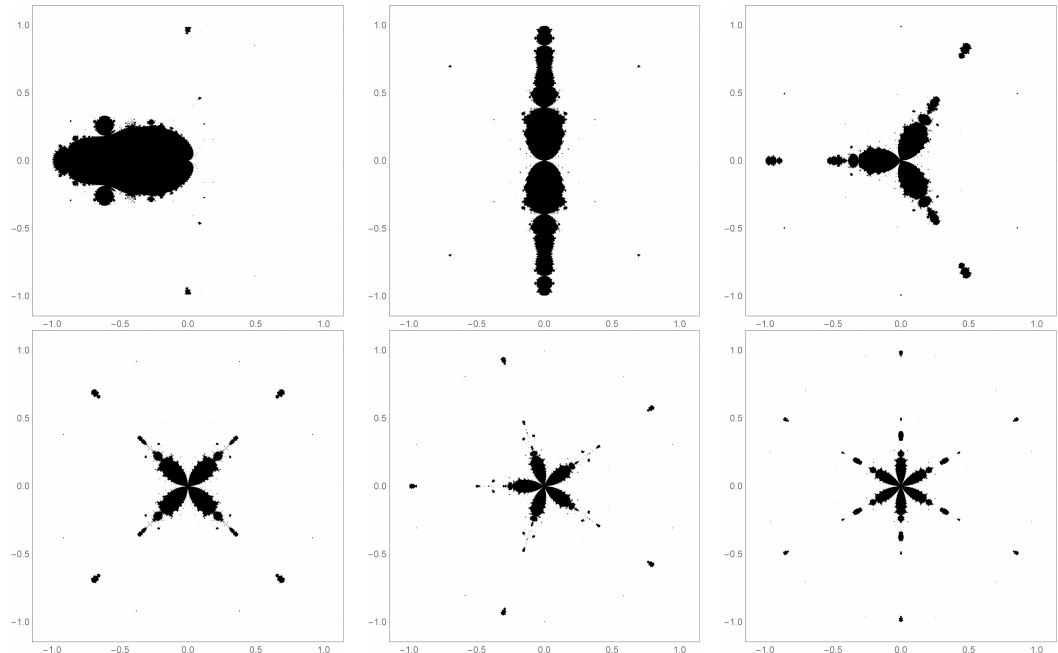
Figure 3. Mandelbrot sets associated with the corresponding lacunary functions (Figure 1 and ( 1 ) ( z ) through 50 h ( 6 ) ( z ) . From top left to bottom right the Hausdorff Julia sets (Figure 2) 50 h 30 30 modified dimension (described in detail in a later section) of the Mandelbrot sets are 1.363, 1.302, 1.300, 1.335, 1.307, 1.261, 1.321 and 1.247